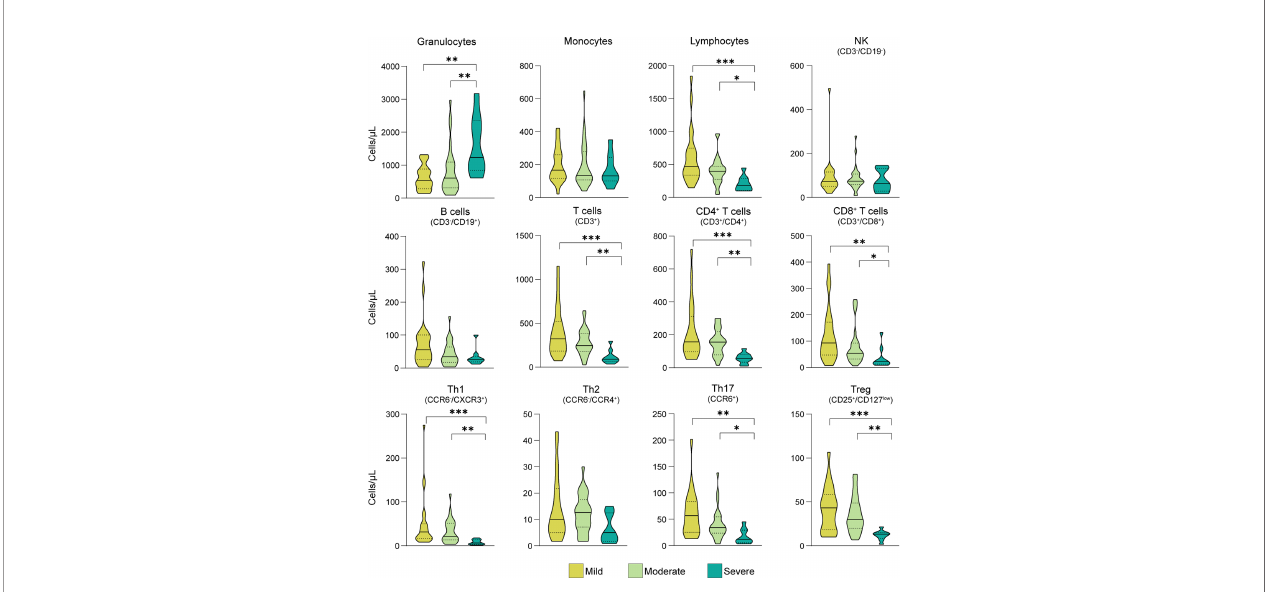
FIGURE 1 | Immunophenotypic analysis in COVID-19 patients classi fi ed according to the severity of the disease. Distribution of the absolute number of cells (expressed as cells/µl of blood) across the three groups of COVID-19 patients suffering from different disease severity, i.e. mild or score 4 (n = 23), moderate or